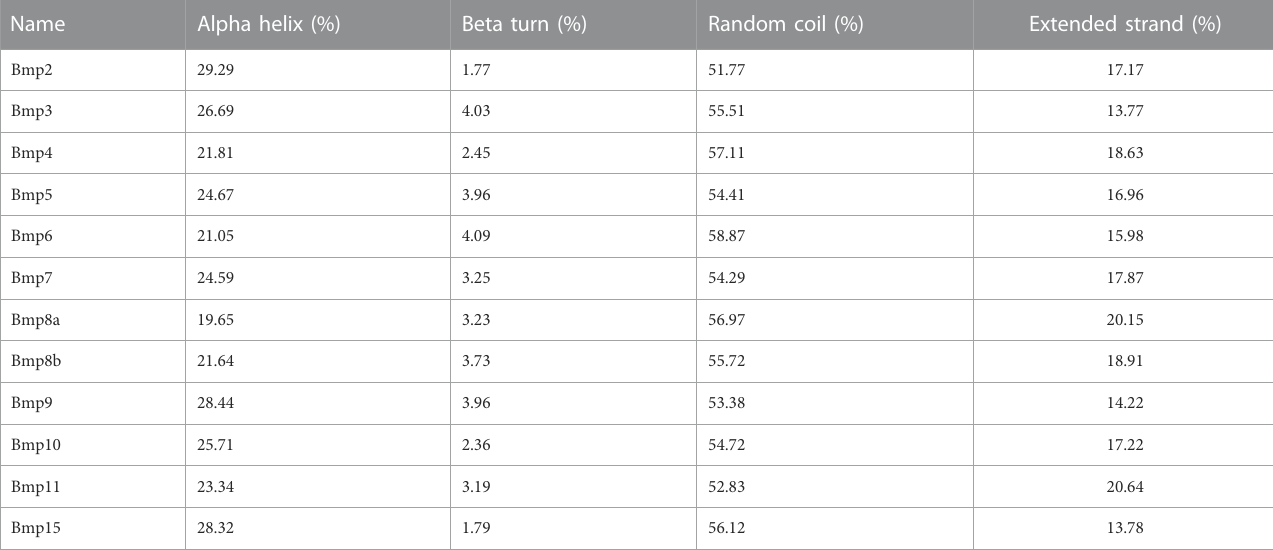
TABLE 3 The secondary structure prediction of BMP proteins in Homo